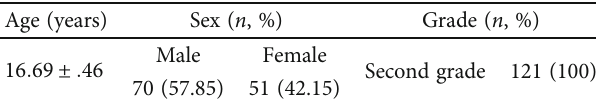
Table 1: General characteristics of the subjects ( n = 121